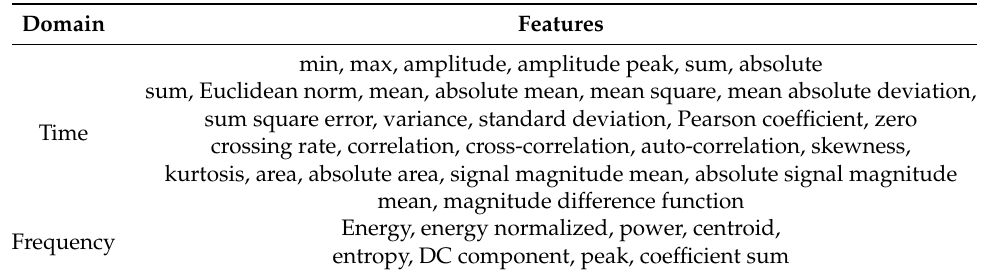
Table 5. List of all features used in the experiments with the baseline TF.